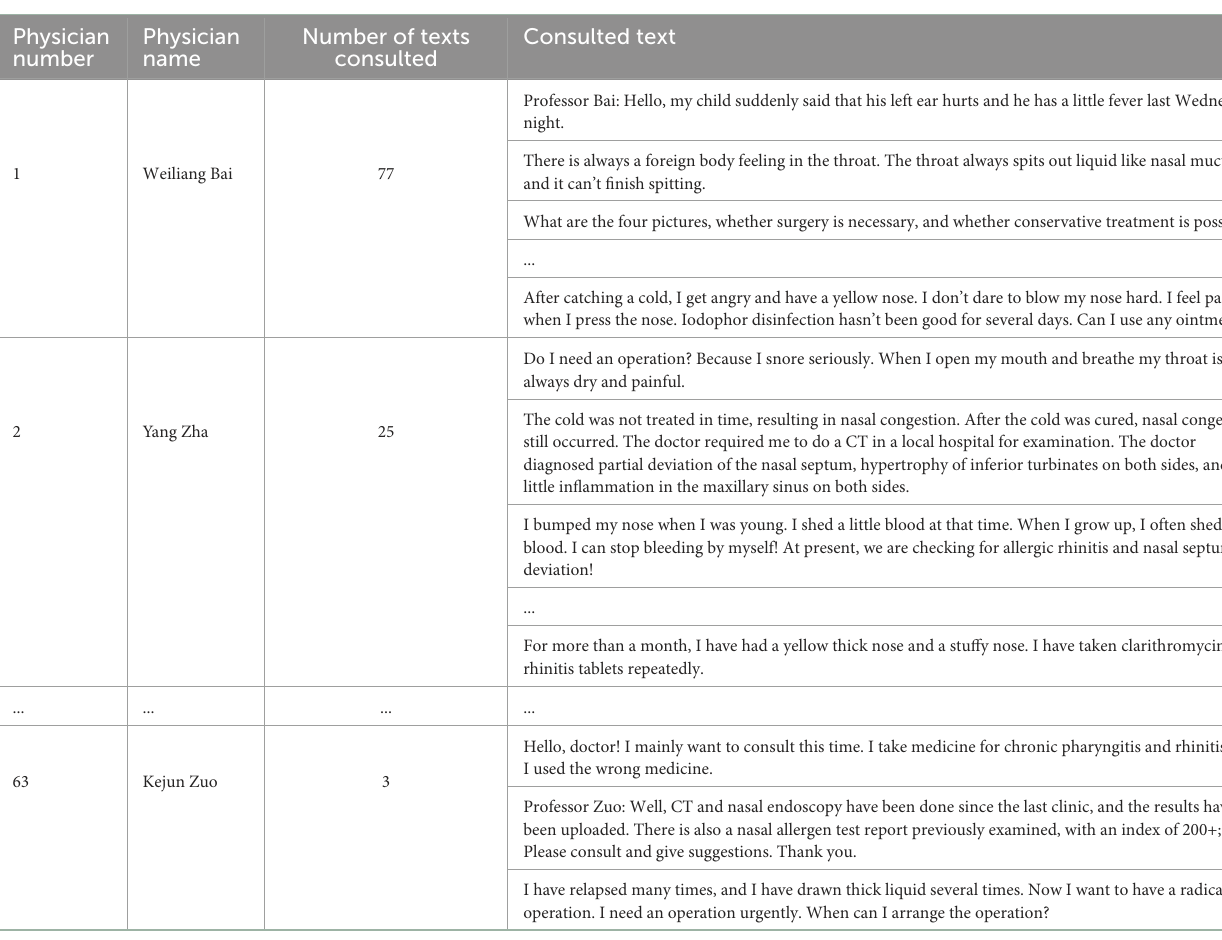
TABLE 3 The related parameter settings.